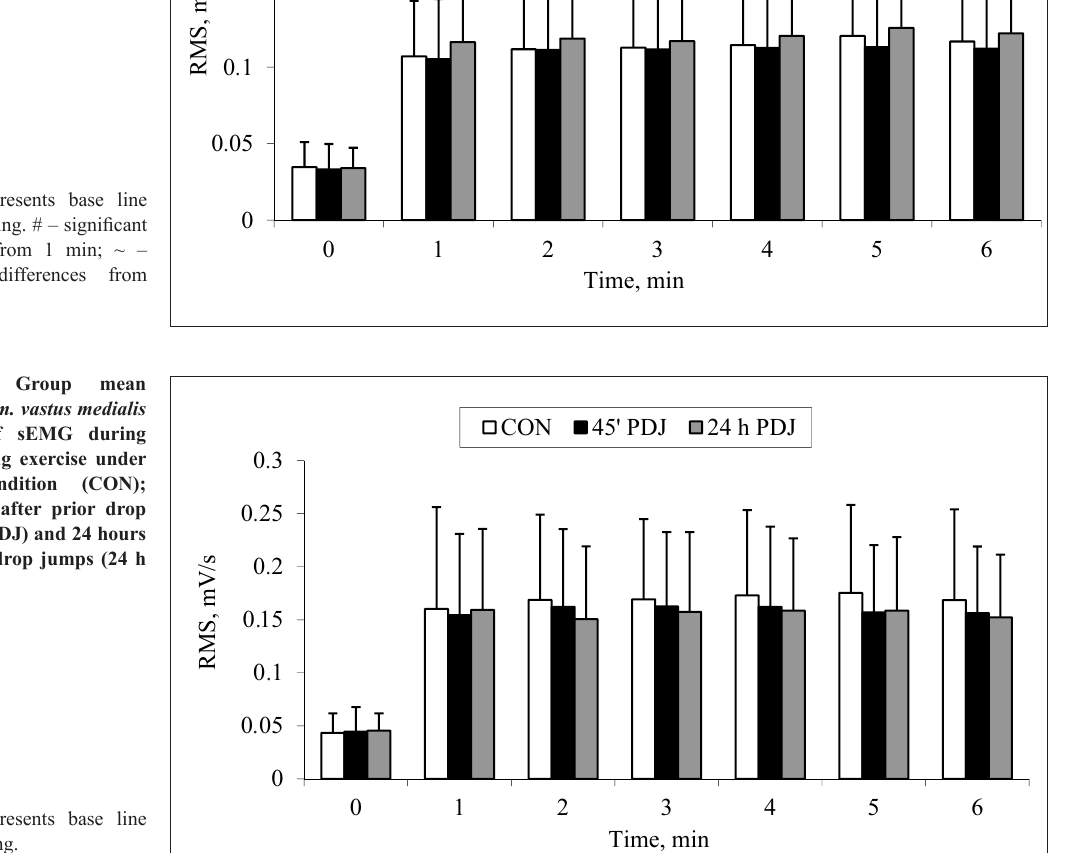
Note. 0 represents base line (20 W) cycling. Figure 3. Group mean response Figure 2. Group mean response of m. vastus medialis in RMS of sEMG during moderate of m. vastus lateralis in RMS of cycling exercise under control condition (CON); 45 minutes after prior drop jumps sEMG during heavy cycling ex - (45’PDJ) and 24 hours after prior drop jumps (24 h PDJ) ercise under control condition (CON); 45 minutes after prior drop jumps (45’PDJ) and 24 hours after prior drop jumps